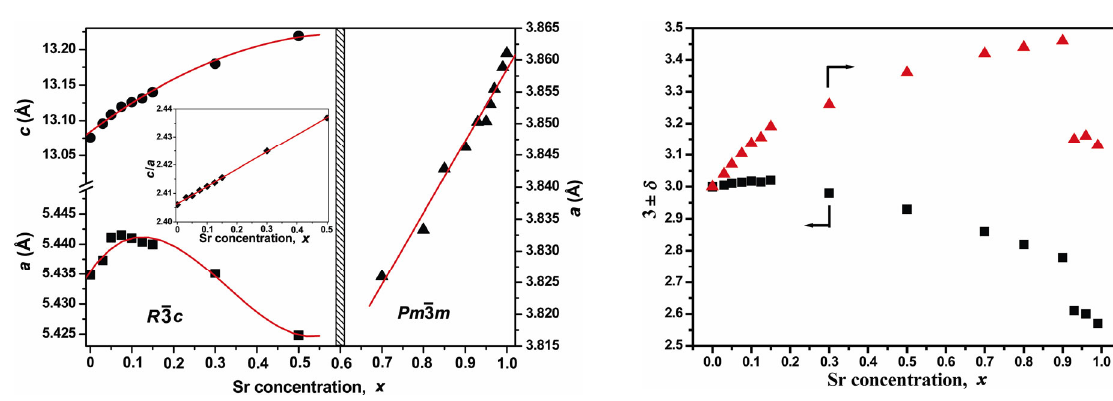
Fig. 4 Variation of lattice parameters as a function of x in La 1– x Sr x CoO 3 .